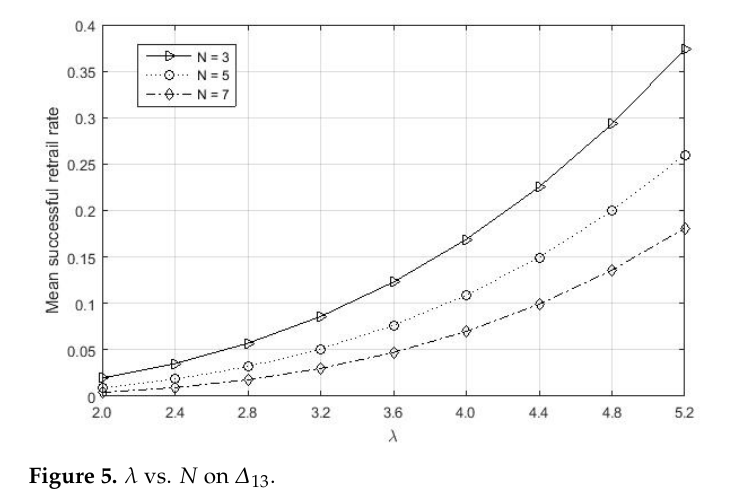
Figure 5. λ vs. N on ∆ 13 .